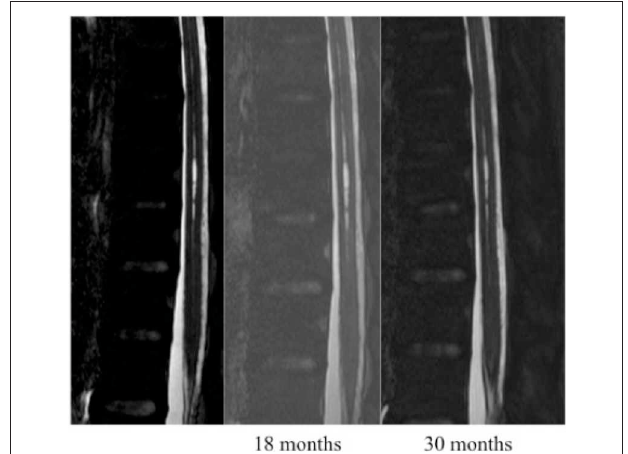
FIGURE 1 | Patient with a typical slitlike cavity.